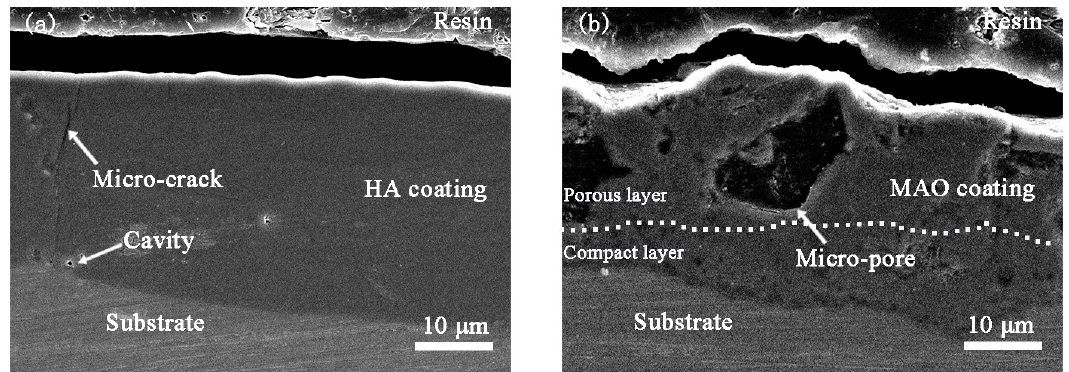
Figure 2. Cross-sectional SEM micrographs of the HA coating ( a ) and the MAO coating ( b ) on the 7050 Al alloy.